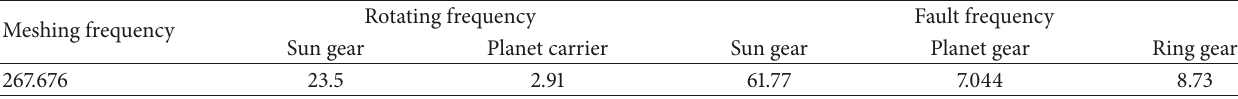
Table 4: Gearbox characteristic frequencies